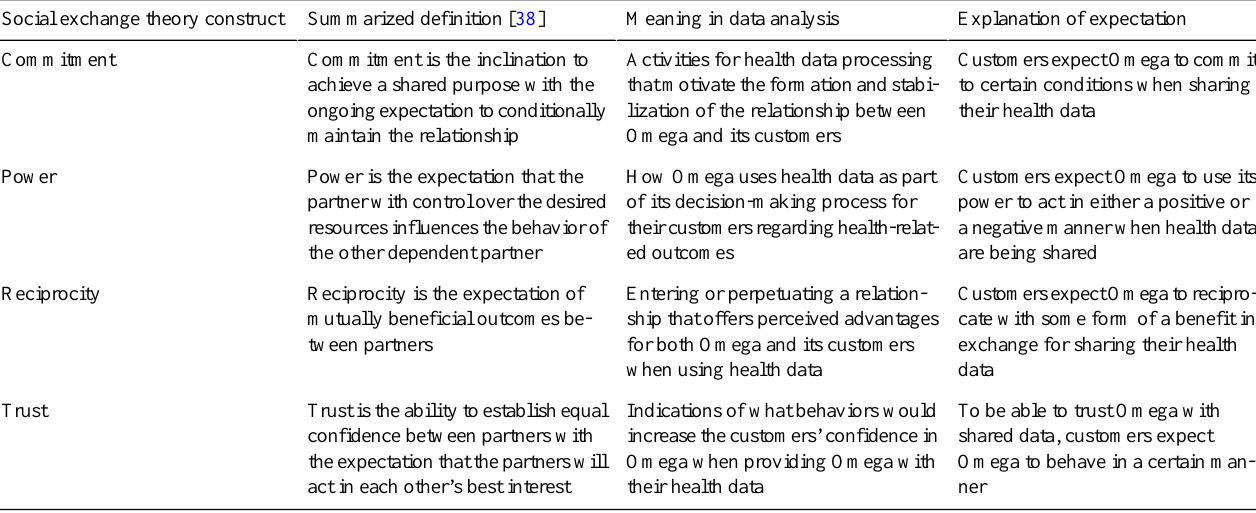
Table 1. Summary of the social exchange theory framework definitions, application for data analysis, and expectation